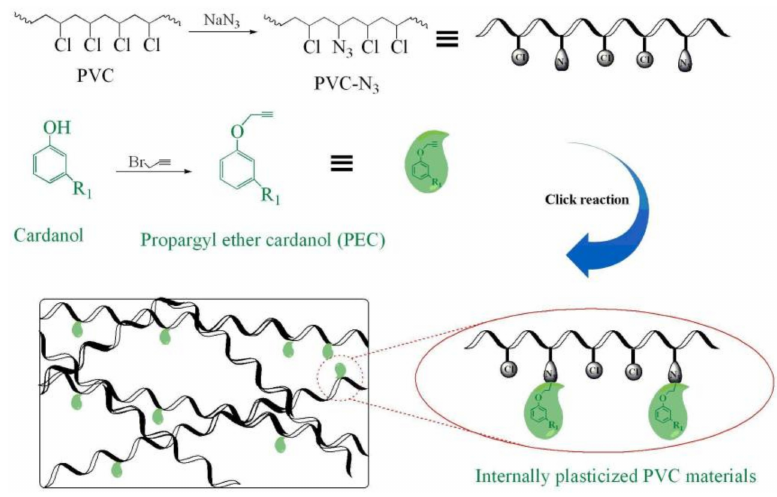
Figure 1. Synthesis of internally plasticized PVC